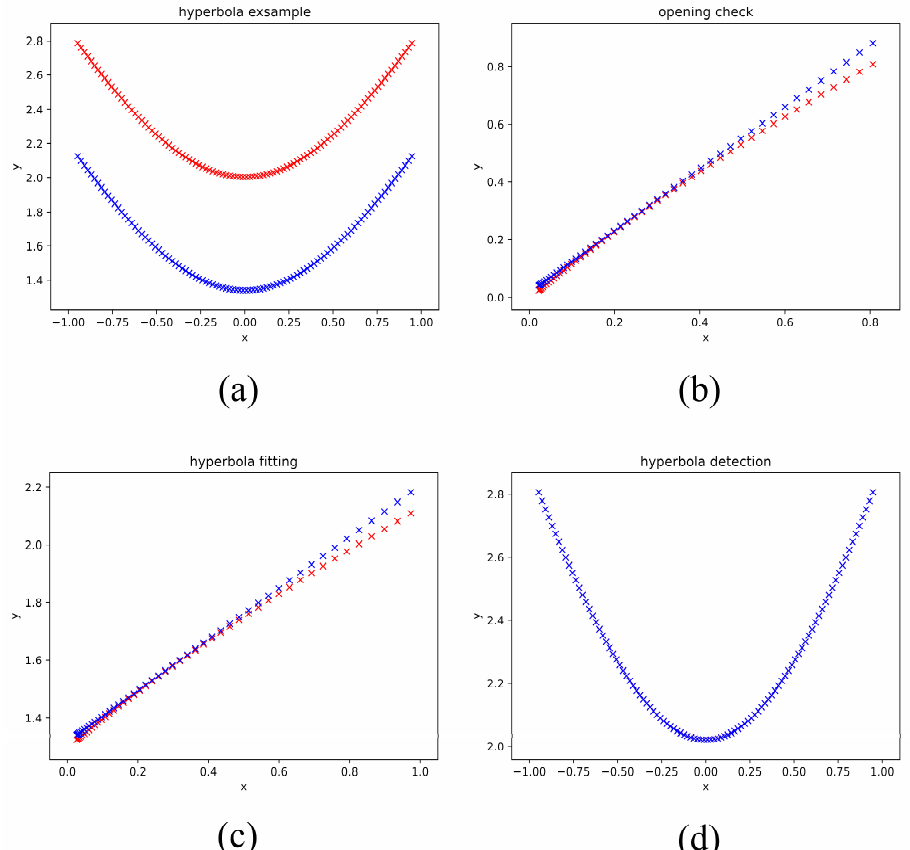
Figure 11. An example for hyperbola fitting with Hough transform. ( a ) The original and shifted hyperbolas hyper. ( b ) The first coordinate transformation for the down opening check. ( c ) The second coordinate transformation for hyperbola fitting. ( d ) The result after hyperbola fitting.